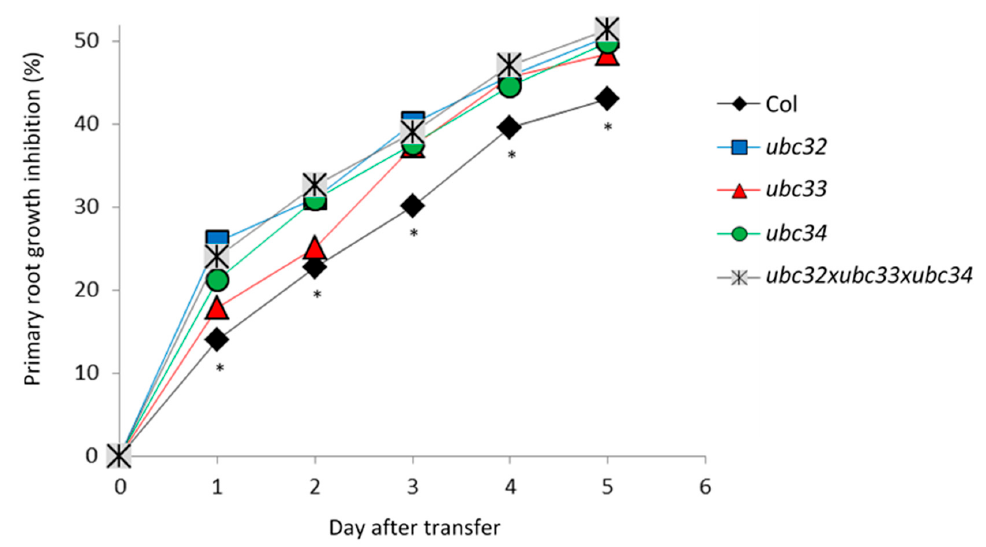
Figure 6. Inhibition of primary root length by mannitol in Arabidopsis thaliana WT plants (Col) and ubc32 , ubc33 , ubc34 , and ubc32xub33xubc34 mutants. Fifteen plants per condition were grown for 5 days in MS medium and then transferred to MS medium and MS medium supplemented with 200 mM mannitol. Primary root length was monitored up to 5 days after transfer (Figure S9). Asterisks (*) mean that the WT is significantly different from at least one mutant in a one-way ANOVA test combined with a Tukey test ( p -value between 0.01 and 0.001 (statistics in Table S8)).